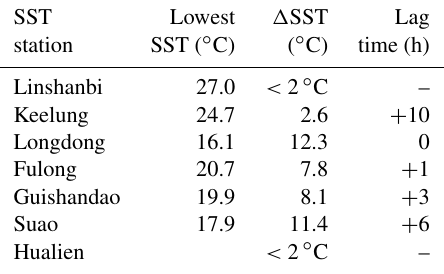
Table 4. Quantities of the SST drop, the lowest SST and their lag time corresponding to the Longdong Buoy during Typhoon Morakot in 2009. A positive lag time value indicates that the SST drop ob- served at the station occurred later than that observed at the Long- dong Buoy. A dash means no significant SST drop was observed. SST Lowest (cid:49)